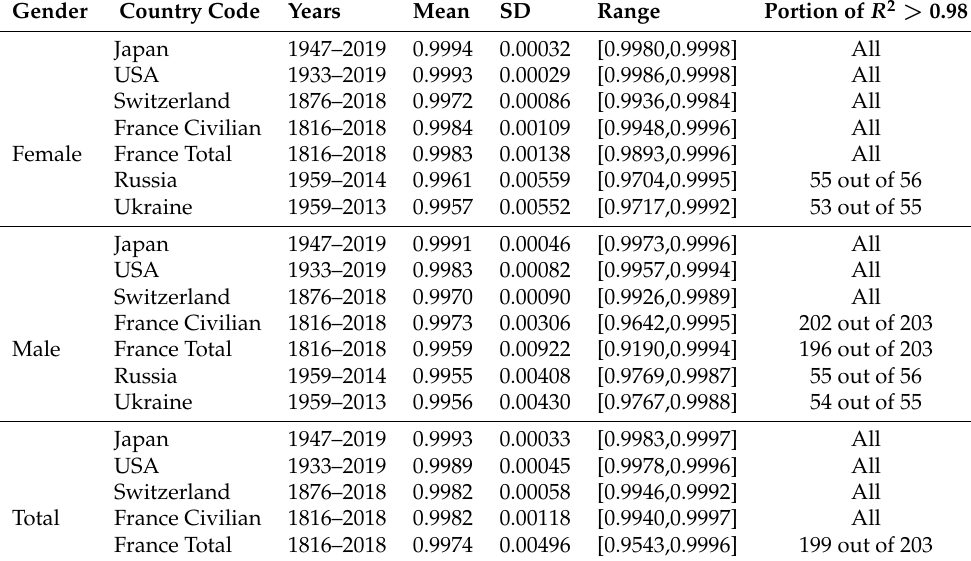
Table 7. R 2 w of the DLGC fitting results.